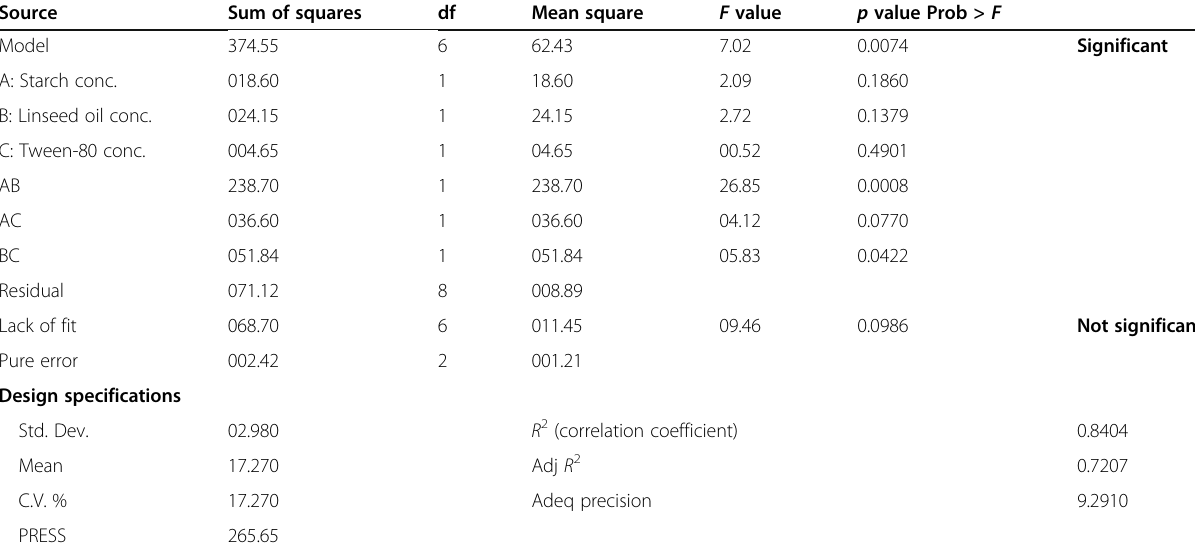
Table 5 ANOVA for response surface in 2-factor interaction (2FI) model